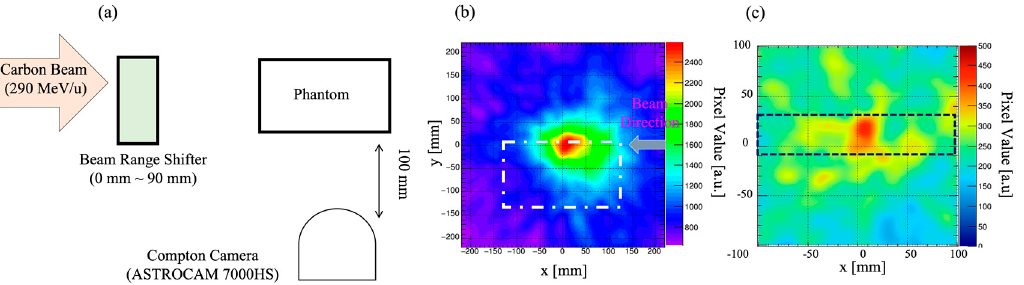
Figure 12. On-beam range monitoring using Si/CdTe Compton camera in CIRT. ( a ) Experimental setup. ( b ) Compton image of 511 keV annihilation gammas [85]. ( c ) Compton image of 718 keV prompt gammas [86]. Dotted line in figures ( b , c ) represents the phantom periphery. All the figures are rearranged and reprinted from Parajuli et al.